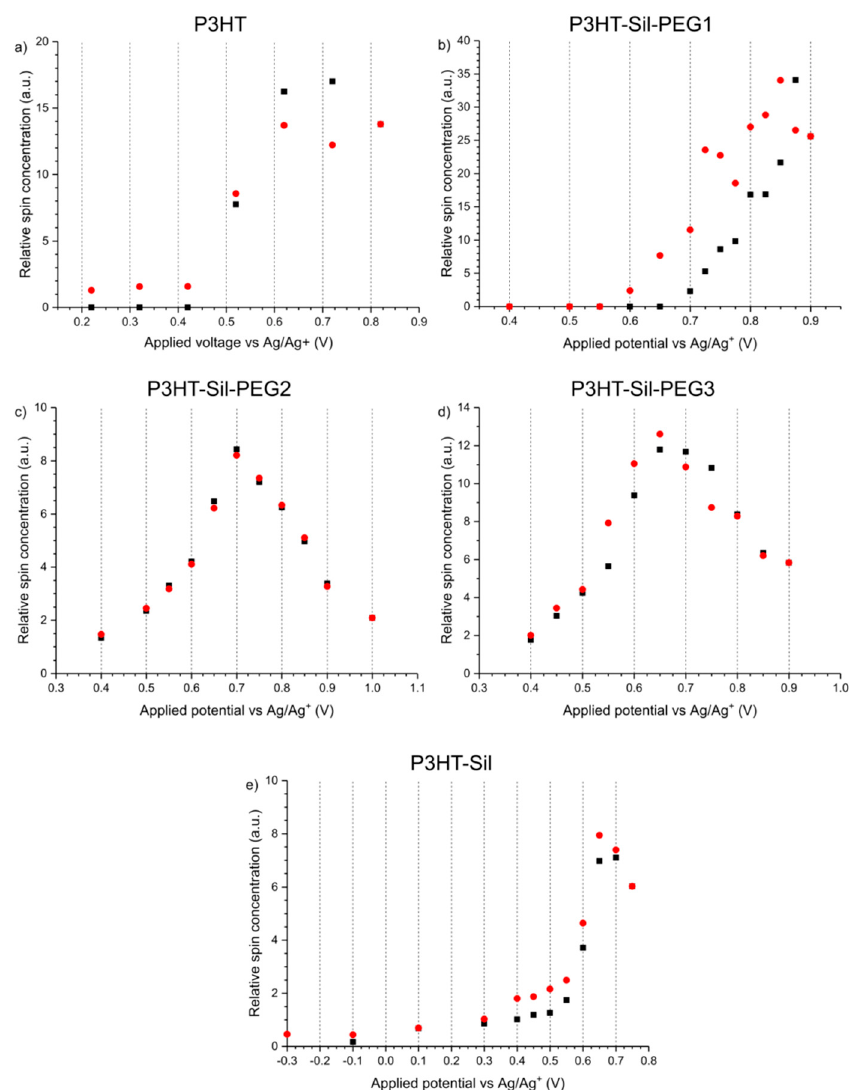
Figure 8. Stepwise EPR spectroelectrochemistry of ( a ) regioregular P3HT; ( b ) P3HT-Sil-PEG1; ( c ) P3HT-Sil-PEG2; ( d ) P3HT-Sil-PEG3; ( e ) P3HT-Sil films on a Pt electrode. Black points denote increasing applied potential (p-doping), whereas red points denote decreasing applied potential (dedoping).